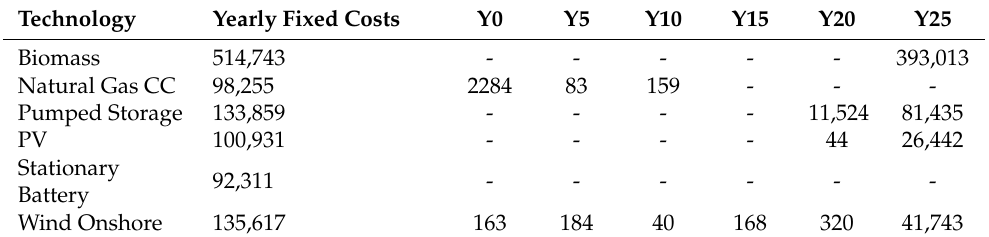
Table 2. Mark-ups on investment cost in iteration 1 for each year (myopic case) [EUR/MW].